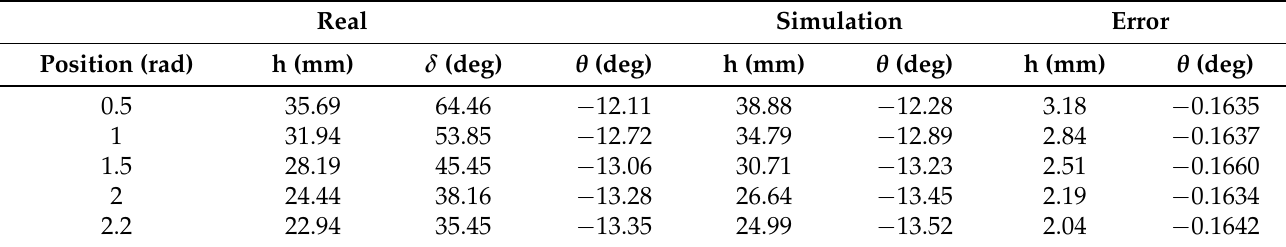
Table 5. Experimental kinematic data indirectly